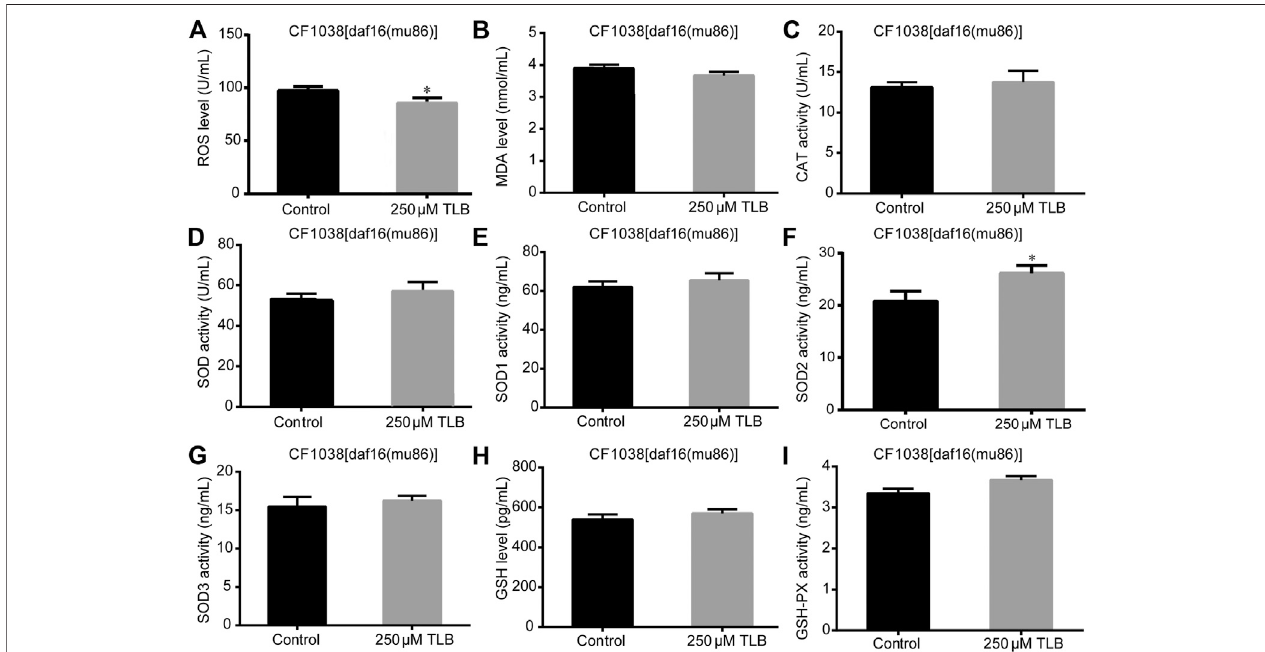
FIGURE7| Anti-oxidanteffectsofTLBDAF16mutant C .elegans . C .elegans wereraisedintheabsenceorpresenceof250 μ MTLBfor72 h.Thetotalproteinof C. elegans wasextracted and centrifuged for10 min at 10,000 × g,4 ° C,then the supernatant was detected using appropriate ELISA kits. (A) ROS level; (B) MDA level; (C) CAT activity; (D) SOD activity; (E) SOD1 activity; (F) SOD2 activity; (G) SOD3 activity; (H) GSH activity; (I) GSH-Px activity. n (cid:2) 1000. Data were presented as mean ± SEM. * p < 0.05 vs. non-TLB treated controls.